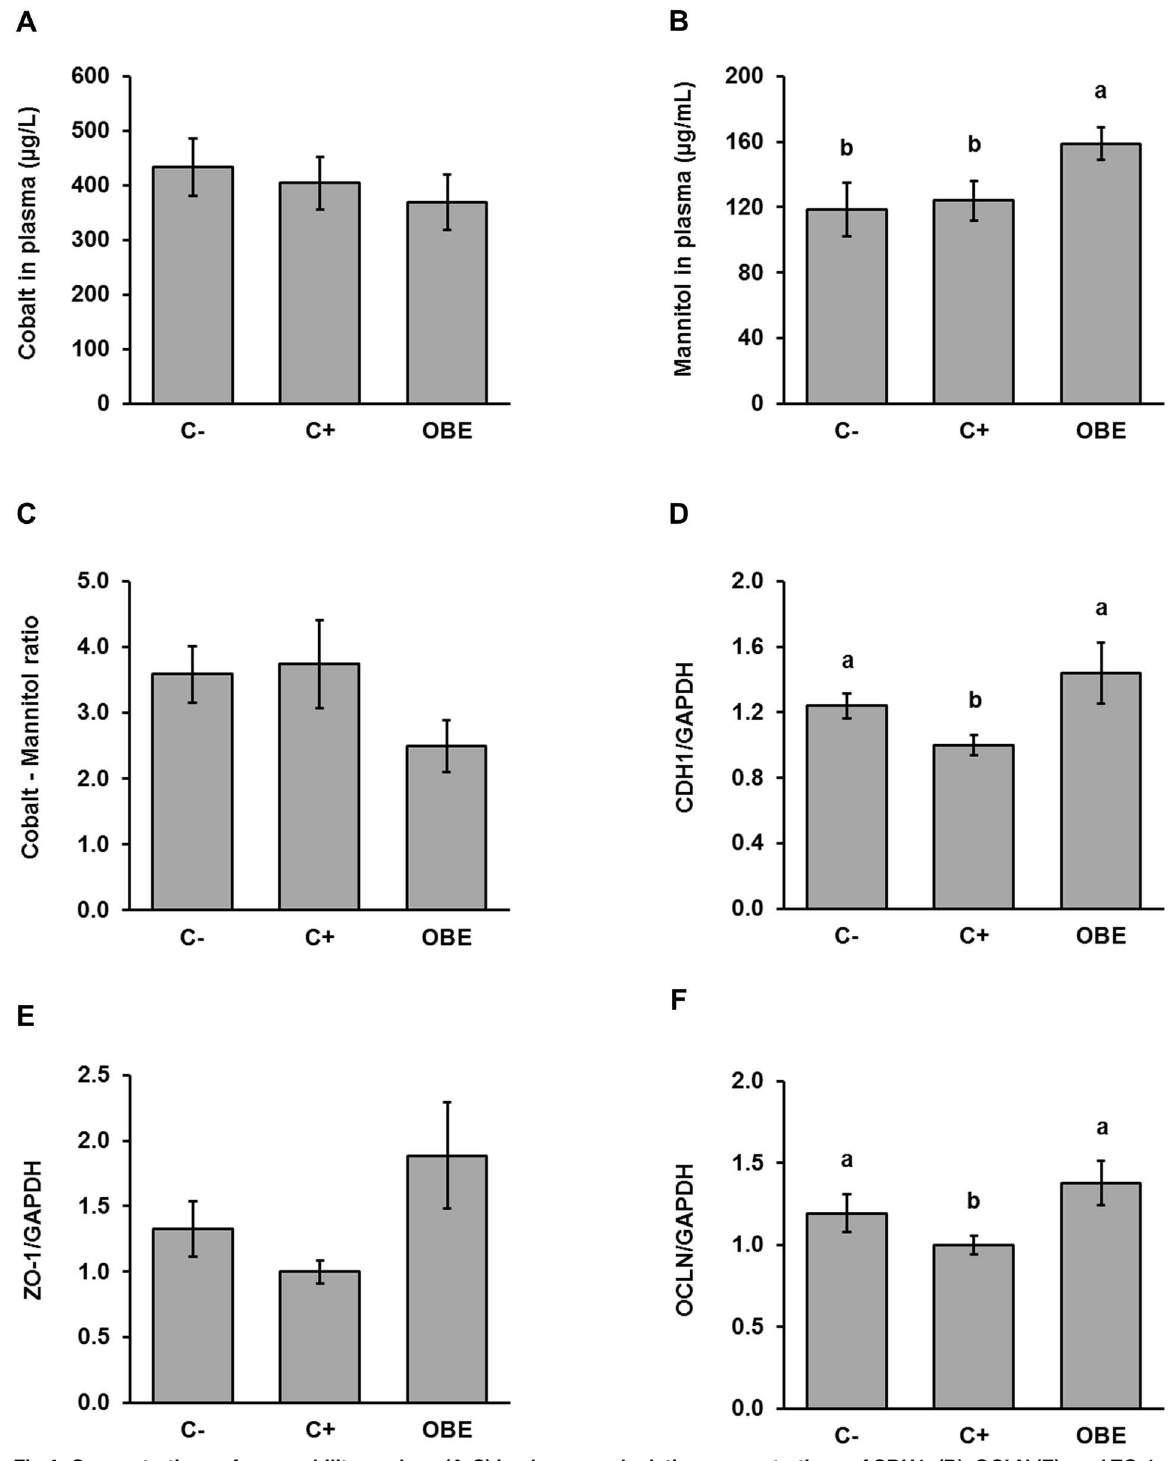
Fig 4. Concentrations of permeability markers(A-C) in plasma and relative concentrations of CDH1; (D), OCLN (E), and ZO-1 (F) in the ileal mucosa of pigs challenged chronically with LPS and fed an Olive-oil Bioactive Extract (OBE). Piglets were fed a standarddiet either untreated(C-, C+) or supplemented with an olive-oilextract (OBE; 500 mg/kg diet). On d 20, 23, 26 and 29, OBE and positive control (C+) pigs received E . coli -derived LPS injectionsat increasingdoses (60, 66, 72 and 78 μ g/kg). Negativecontrol animals(C-) were injectedwith saline. Plasma samples were collected via jugularvenipuncture 1 h after intragastric infusionof the